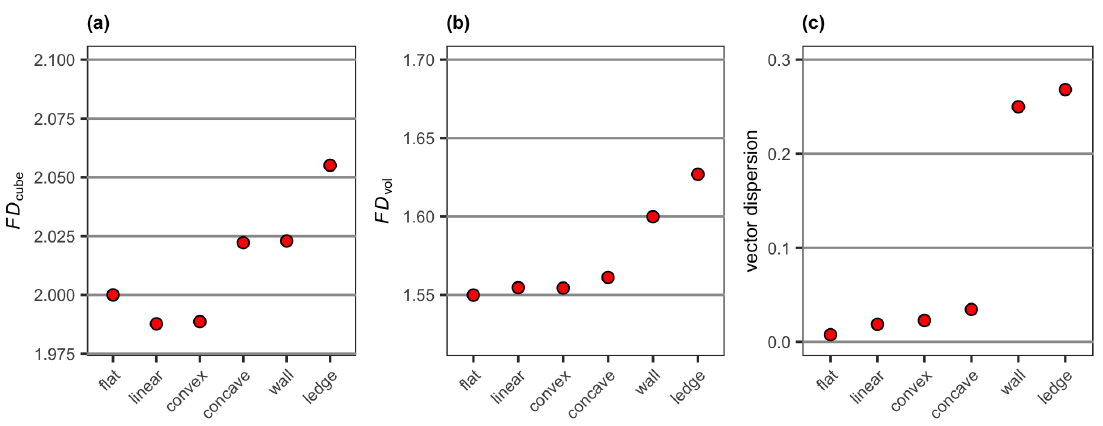
Figure 10. Values of ( a ) FD cube , ( b ) FD vol and ( c ) vector dispersion extracted from the 3D mesh models of the six simulated surface